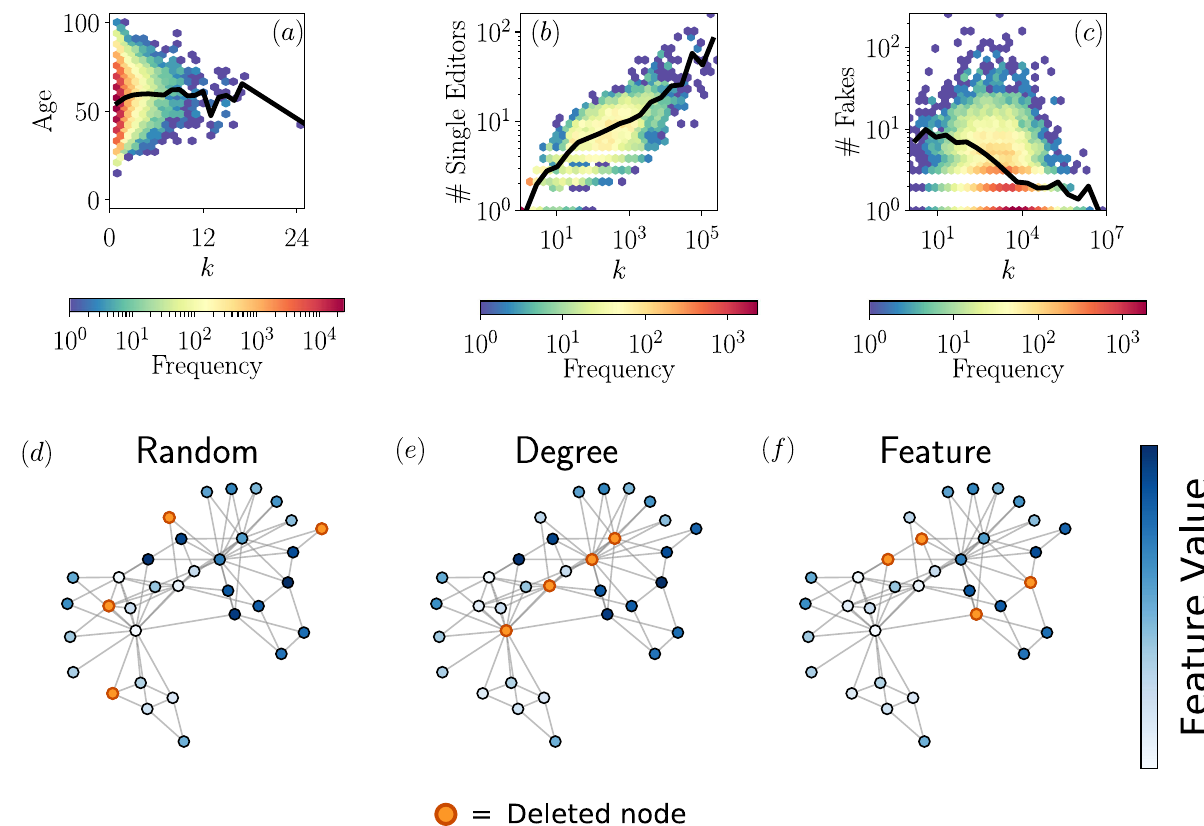
Fig. 1 Empirical evidence of different feature-degree patterns and sketch of different types of removal protocols in the percolation process. a Correlation between the degree of a director of a company (number of companies in which she participates) and her age. Data from 67 . b Wikipedia pages show a positive correlation between the hyperlinks present in an article (out-degree) and the number of unique editors that have modi fi ed such article. Data from an updated version of the ref. 68 . c Negative correlation between the number of followers and the number of fake news posted by a user. The subset of data taken from 69 , comprising worldwide users during the fi rst two weeks of April 2020. The black solid lines correspond to the mean value of the data. In the bottom row, we show how different interventions can affect the network. In the random case ( d ) nodes are chosen equiprobably to be deleted. In the degree case ( e ), the removed nodes are those with the largest number of connections. In the feature case ( f ), the selected elements are those with the largest value of the feature (the darkest blue). In this example, the values of the feature have been assigned manually for convenience and the feature vector F has been considered